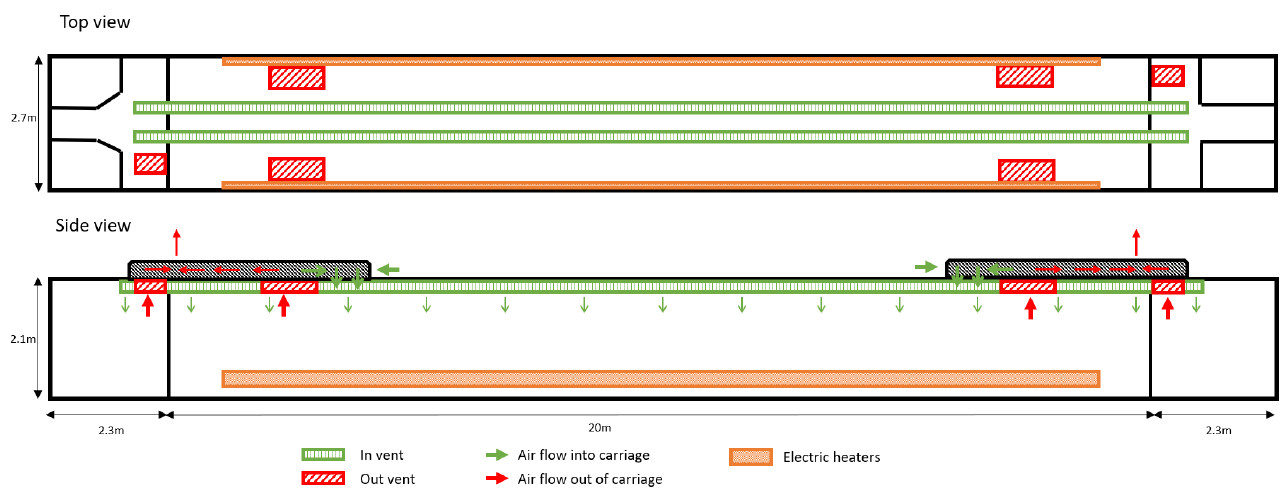
Figure 2. Schematic of carriage ventilation. Air is supplied from the ceiling along the entire length of the carriage. Extract vents are located at either end of the saloon and in each vestibule. A large proportion of the air is recirculated back into the